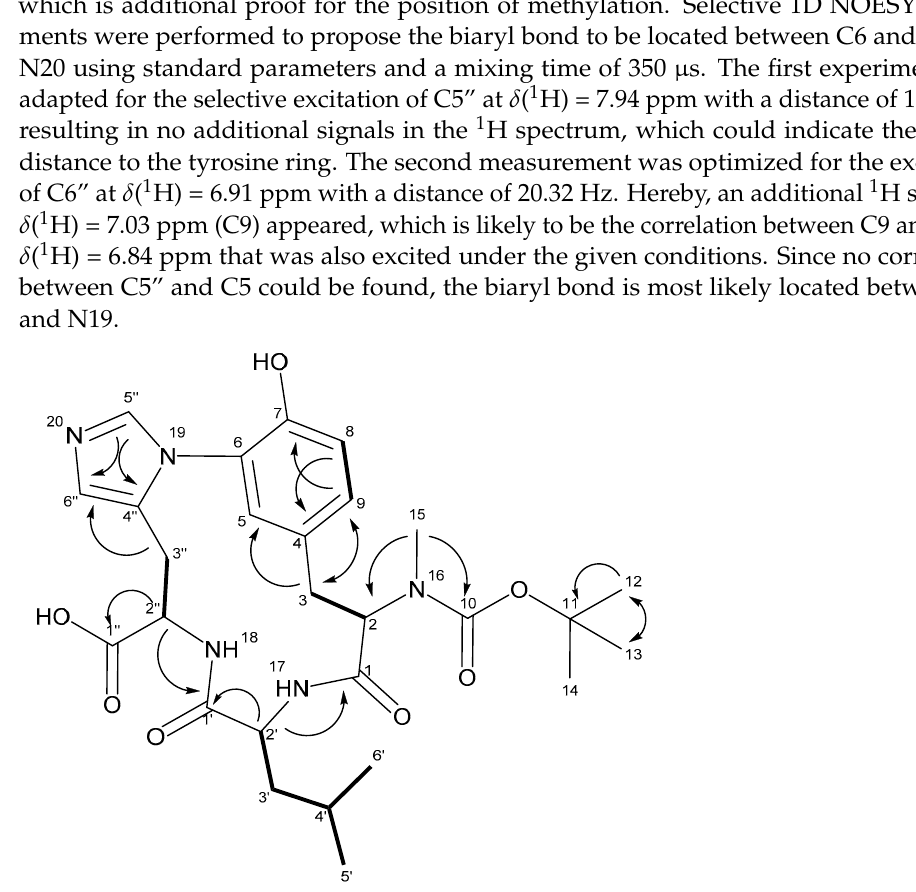
Figure 4. Atom numbering and selected COSY (bold) and HMBC (plain) correlations of 2 .